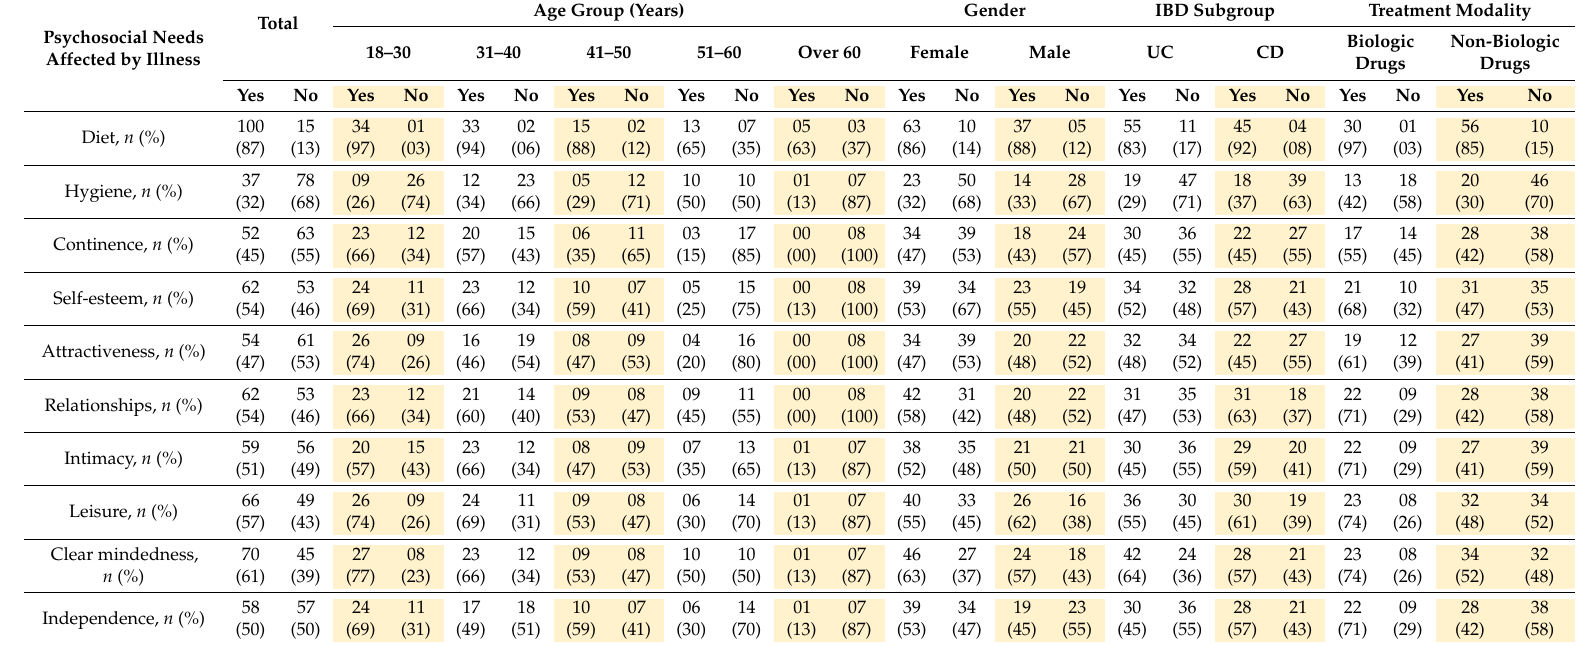
Table 2. Comparison of psychosocial needs by age, gender, IBD subgroup and treatment